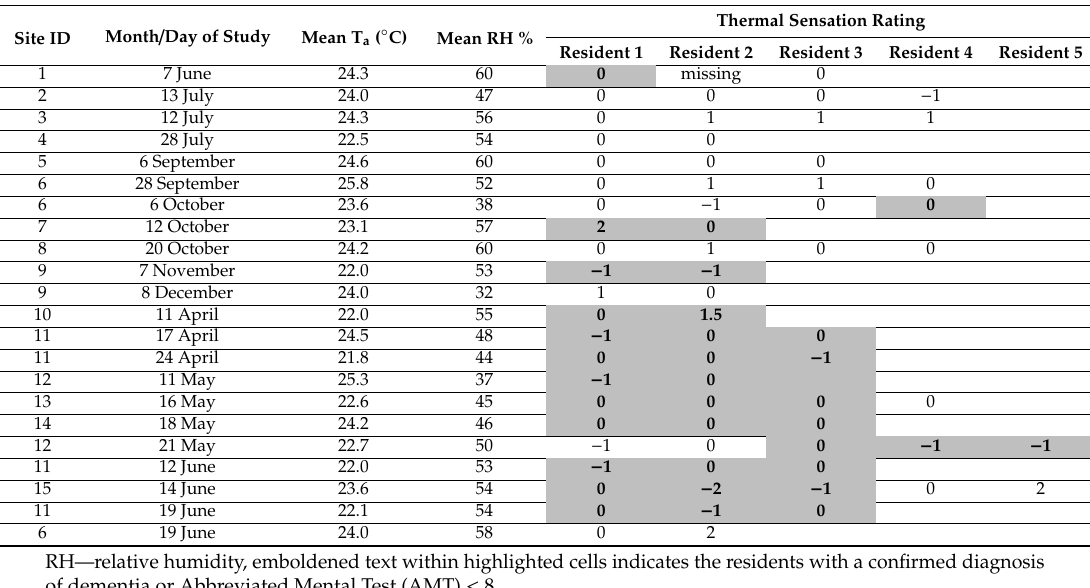
Table 2. Individual thermal sensation ratings reported by residents sharing the same environmental conditions at each imaging session in groups of two to five. Study undertaken over a period of 12 calendar months at 15 residential care sites. Residents with dementia who participated in the imaging sessions are identified by highlighted and emboldened text. Four residential care sites (6,9,11,12) were visited